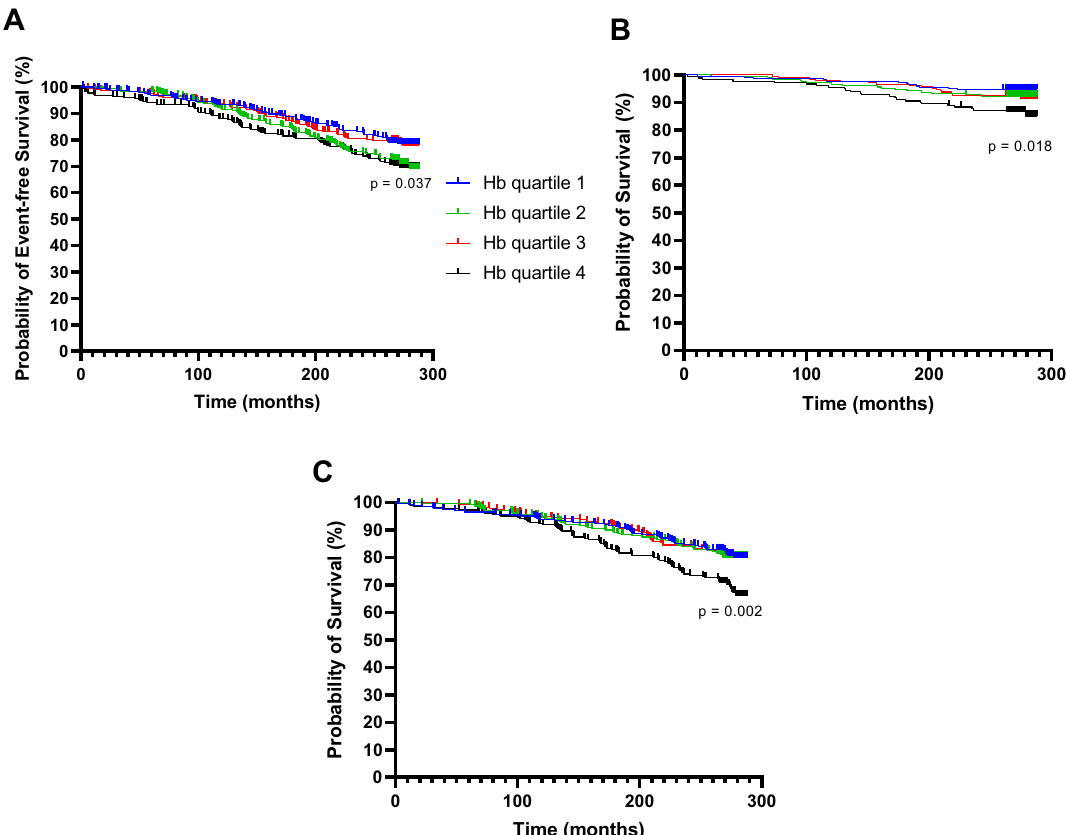
Figure 4. Survival probability according to Hb quartiles. Kaplan–Meier graphs representing survival probabilities for CVD events (n = 231, 23.8%), CVD-related mortality (n = 70, 7.2%) and total mortality (n = 213, 22%) and in each Hb quartile. Hb quartile 1 has the lowest and Hb quartile 4 the highest Hb levels. ( A ) CVD events, ( B ) CVD-related mortality, ( C ) Total mortality. Hb hemoglobin.